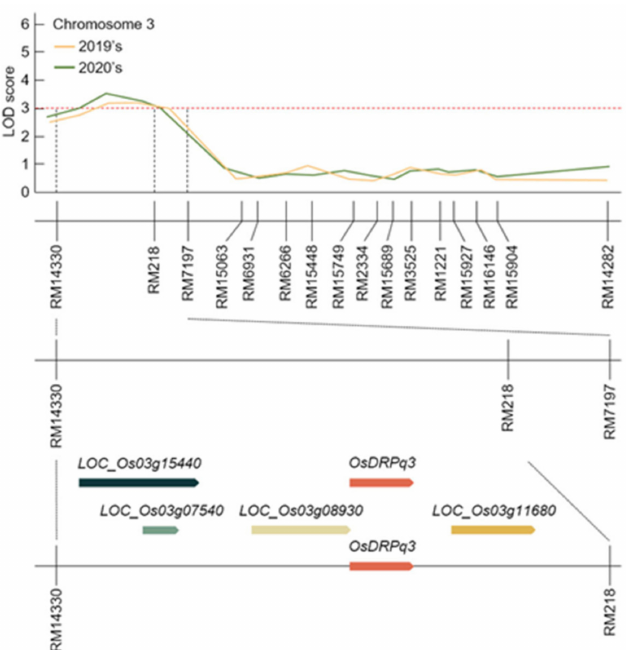
Figure 4. Physical map related to awn development and yield genes. The LOD score of RM14330- RM197 in chromosome 3 was 3.0, and the LOD score of RM14330-RM197 was 3.6. In particu- lar, RM14330-RM218 was commonly detected with an LOD score of 3.0 or higher, and screen- ing of all ORFs detected was related to awn development. LOC_Os03g15440, LOC_Os03g07540, and LOC_Os03g08930 are related to bHLH dimerization region bHLH domain-containing protein. LOC_Os03g11600 is related to drooping leaf protein. LOC_Os03g11680 is related to similar to zinc finger protein. LOC_Os03g11600 is a gene involved in yield and awn elongation. Therefore, LOC_Os03g11600 was finally detected among five ORFs and named OsDRPq3